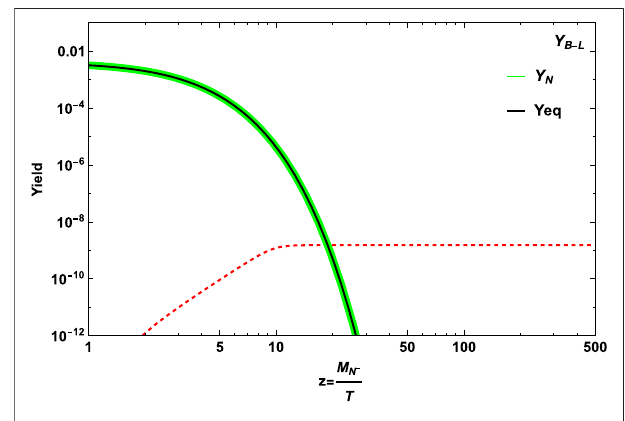
FIGURE 4 | Correlation plot demonstrating the dependence of CP asymmetry with the parameter r N .